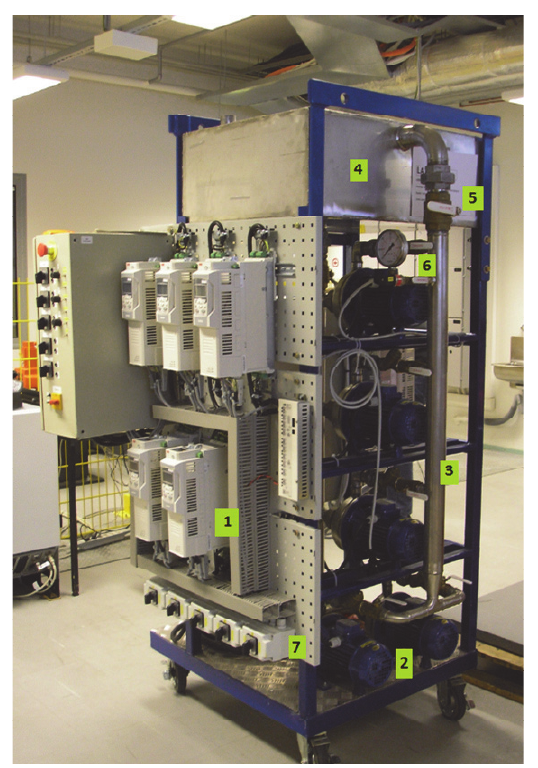
Fig. 6. Experimental setup: (1) ACQ810 frequency converter; (2) EbaraCDX120/12 centrifugal pump; (3) pipeline with 2-inch inner diameter; (4) fluid reservoir; (5) throttling valve; (6) pressure sensor.